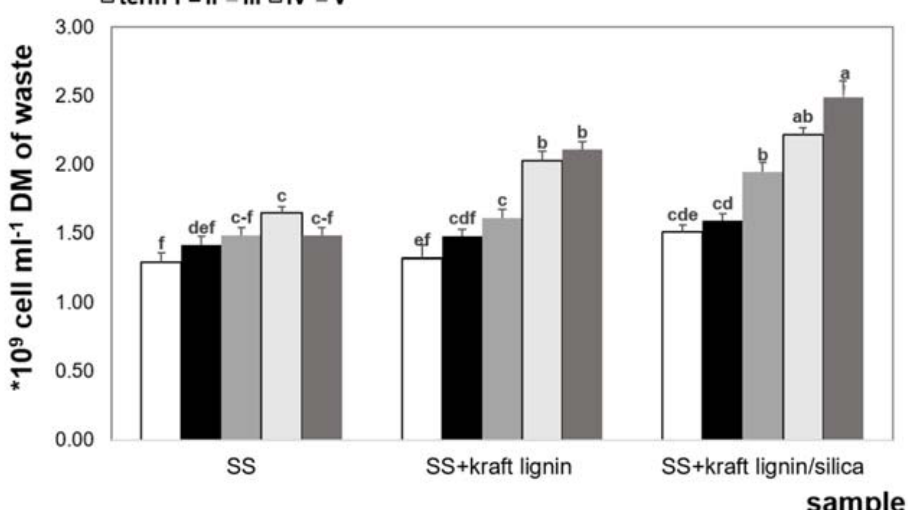
Figure 11. Changes in the total bacterial count in the digested samples. Explanation: a–f—different letters denote significant differences at p = 0.05 ( significance level ) . Means followed by the same letters do not differ significantly at p = 0.05.